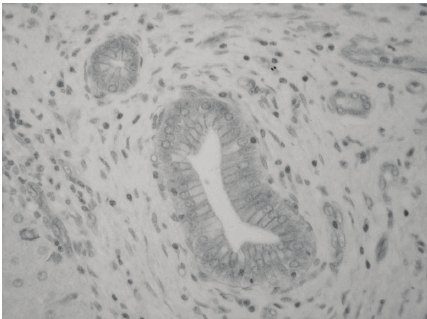
Figure 1: Representative expression pattern of TLR4 in interlobular bile ducts. Membranous (mainly lateral) in addition to weakly cytoplasmic expression is found in Primary biliary cirrhosis. Immunohistochemistry for